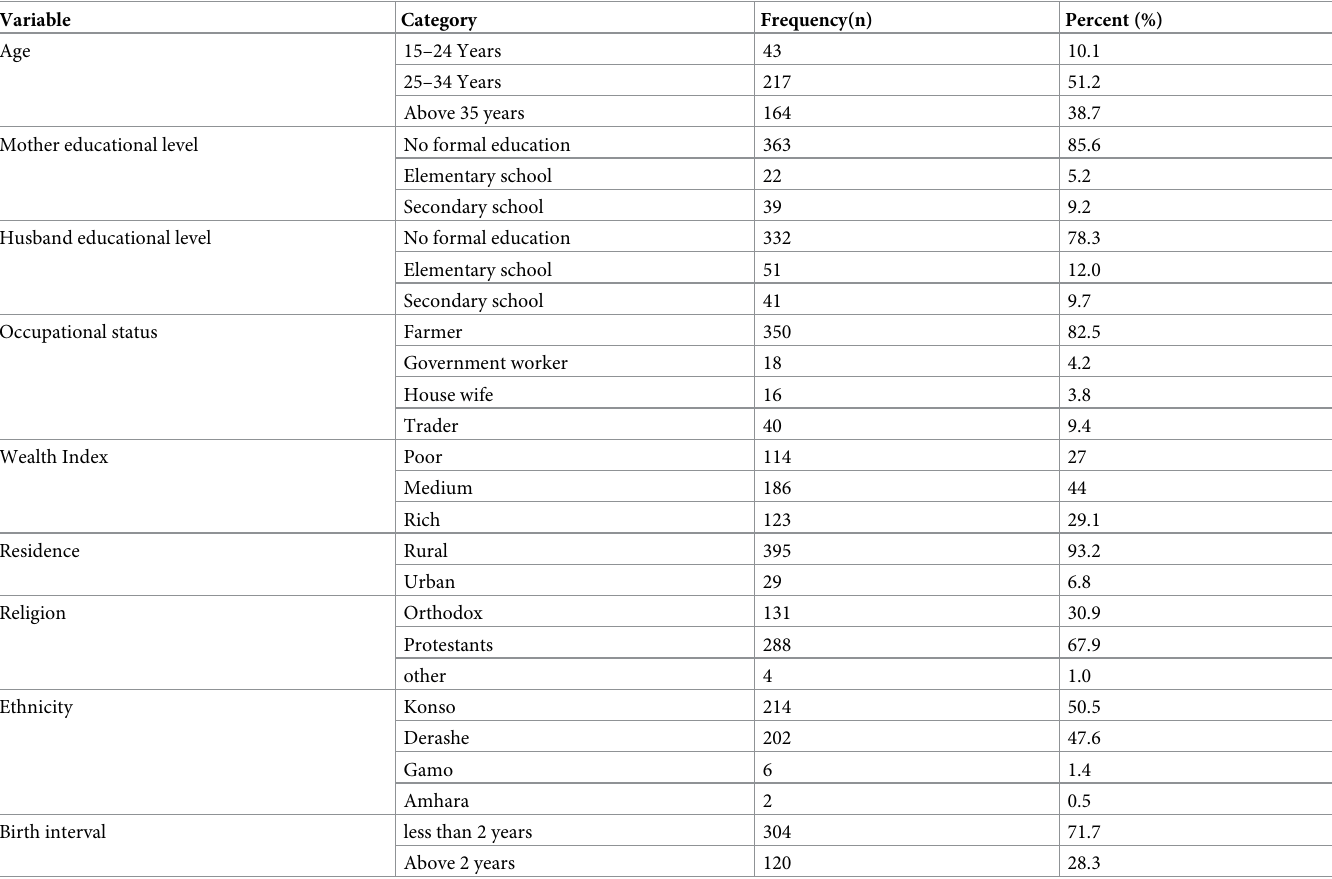
Table 1. Socio-demographic characteristics of the pregnant women (n = 424) attending antenatal clinics of Konso Zone, public health facilities, Southern Ethiopia,